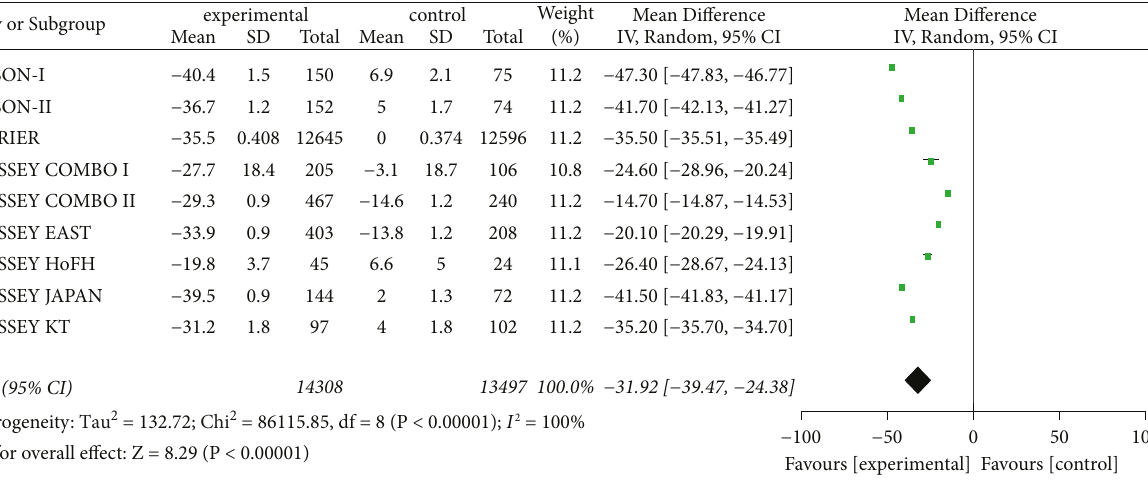
Figure 5: Comparison of the reduction of serum TC (%) from baseline between control group and experimental